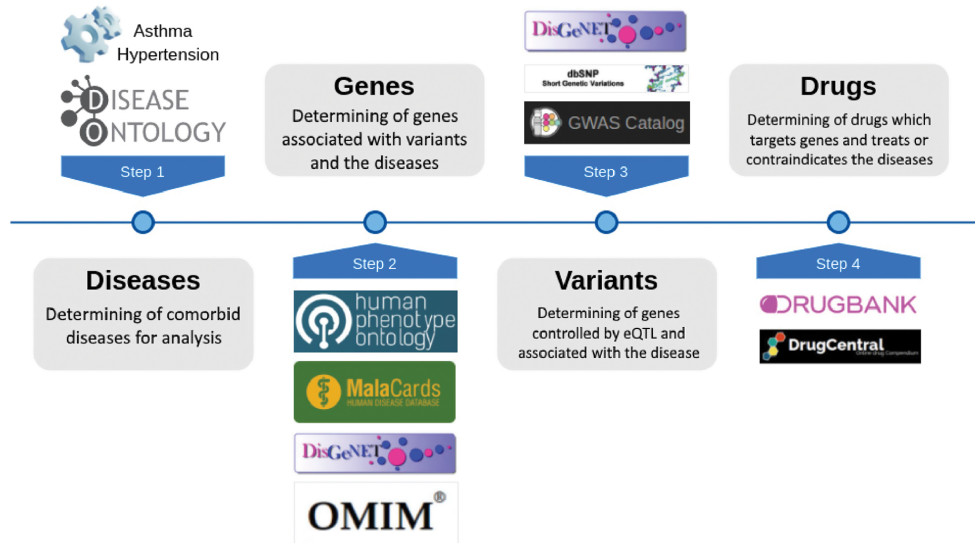
Figure 1: Four steps of the workflow system for generating GenCoNet semi-automatically. First, the comorbidities of high interest in molecular medicine were determined. Essential hypertension and bronchial asthma are considered as an example of common comorbid diseases. Disease Ontology terms associated with genes were obtained from Osborne et al. [16]. Second, human genes that are associated with diseases and variants were obtained from Human Phenotype Ontology (HPO) [17], MalaCards [18], DisGeNet [19], and OMIM [20]. In particular, human genes were extracted from these databases that may cause familial syndromes (Mendelian forms). HPO and DisGeNet provide several database subsets from which the “ FRE- QUENT_FEATURES ” marked data for HPO and “ curated ” marked data for DisGeNet were used.